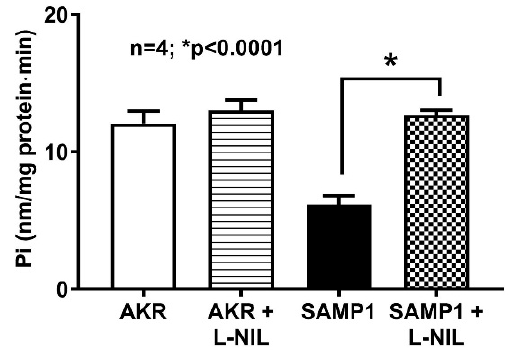
Figure 5. Effect of L-NIL treatment on Na + /K + -ATPase activity . Na + /K + -ATPase activity which was significantly reduced in SAMP1 mice intestinal villus cells was reversed back to normal levels by L- NIL treatment. L-NIL treatment did not change Na + /K + -ATPase activity in AKR mice intestinal villus cells.